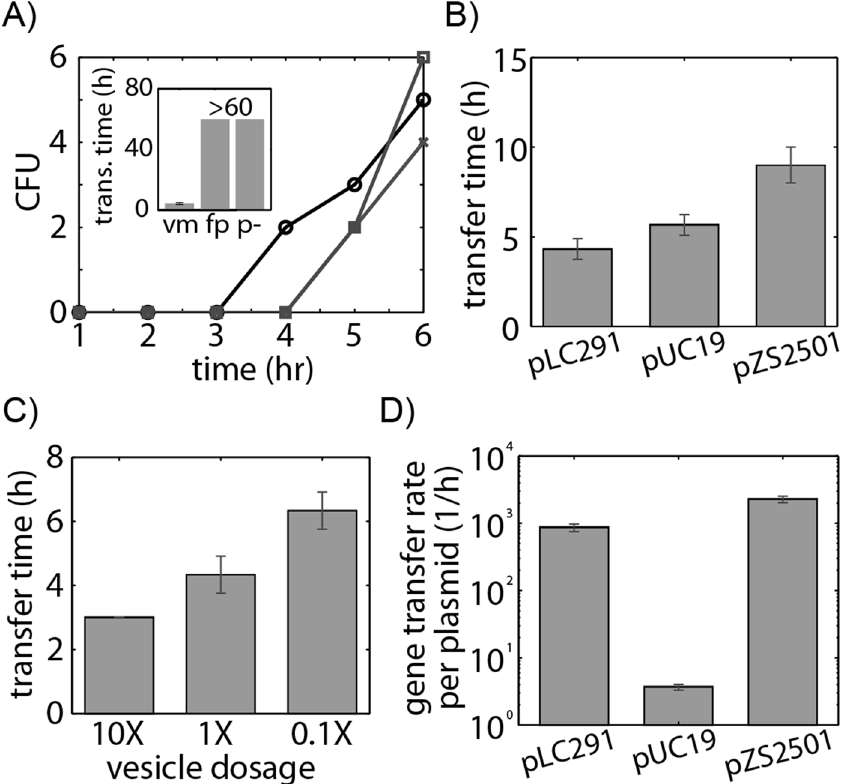
Figure 2. EVs facilitate HGT of multiple plasmids at a rate dependent on plasmid origin. ( A ) Purified EVs loaded with pLC291 were added to a recipient strain culture. Over time, the gain of antibiotic resistance was monitored by selective plating. The three curves show replicate experiments. The transfer time is the average time point at which resistant colonies were first observed. Inset shows recipient cells receiving either free plasmids (fp) or vesicles harvested from cells not containing the plasmid (p-) did not gain resistance by t = 60 h, whereas vesicle-mediated transfer (vm) occurred at 3.7 h. ( B ) Transfer time for EVs containing the plasmids pLC291, pUC19, and pZS2501. All pairs of transfer times have p-values < 0.05. ( C ) Gene transfer assay for three doses of vesicles containing pLC291. 1X corresponds to EV solution with 0.01 mg of characteristic outer- membrane protein (20% of total harvested). ( D ) Transfer rates for each plasmid were normalized by the number of plasmids per vesicle. Transfer rates have p-values < 0.001. Error bars signify standard